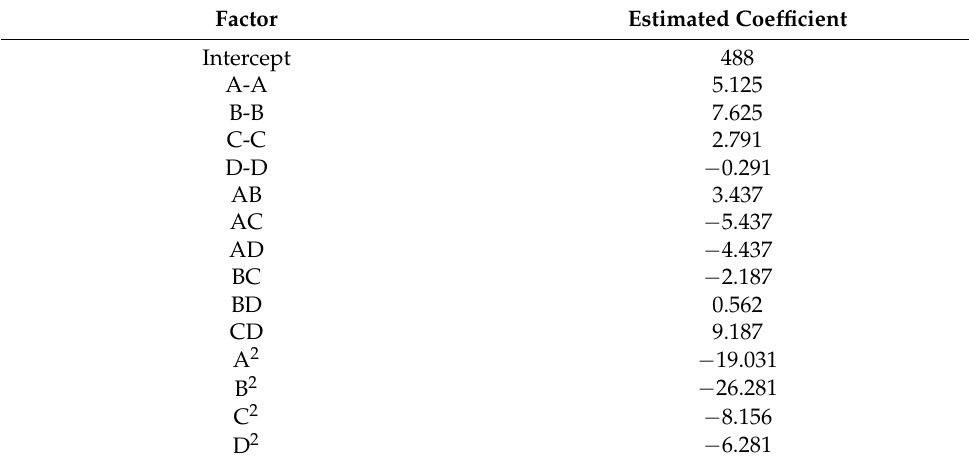
Table 5. Estimated regression